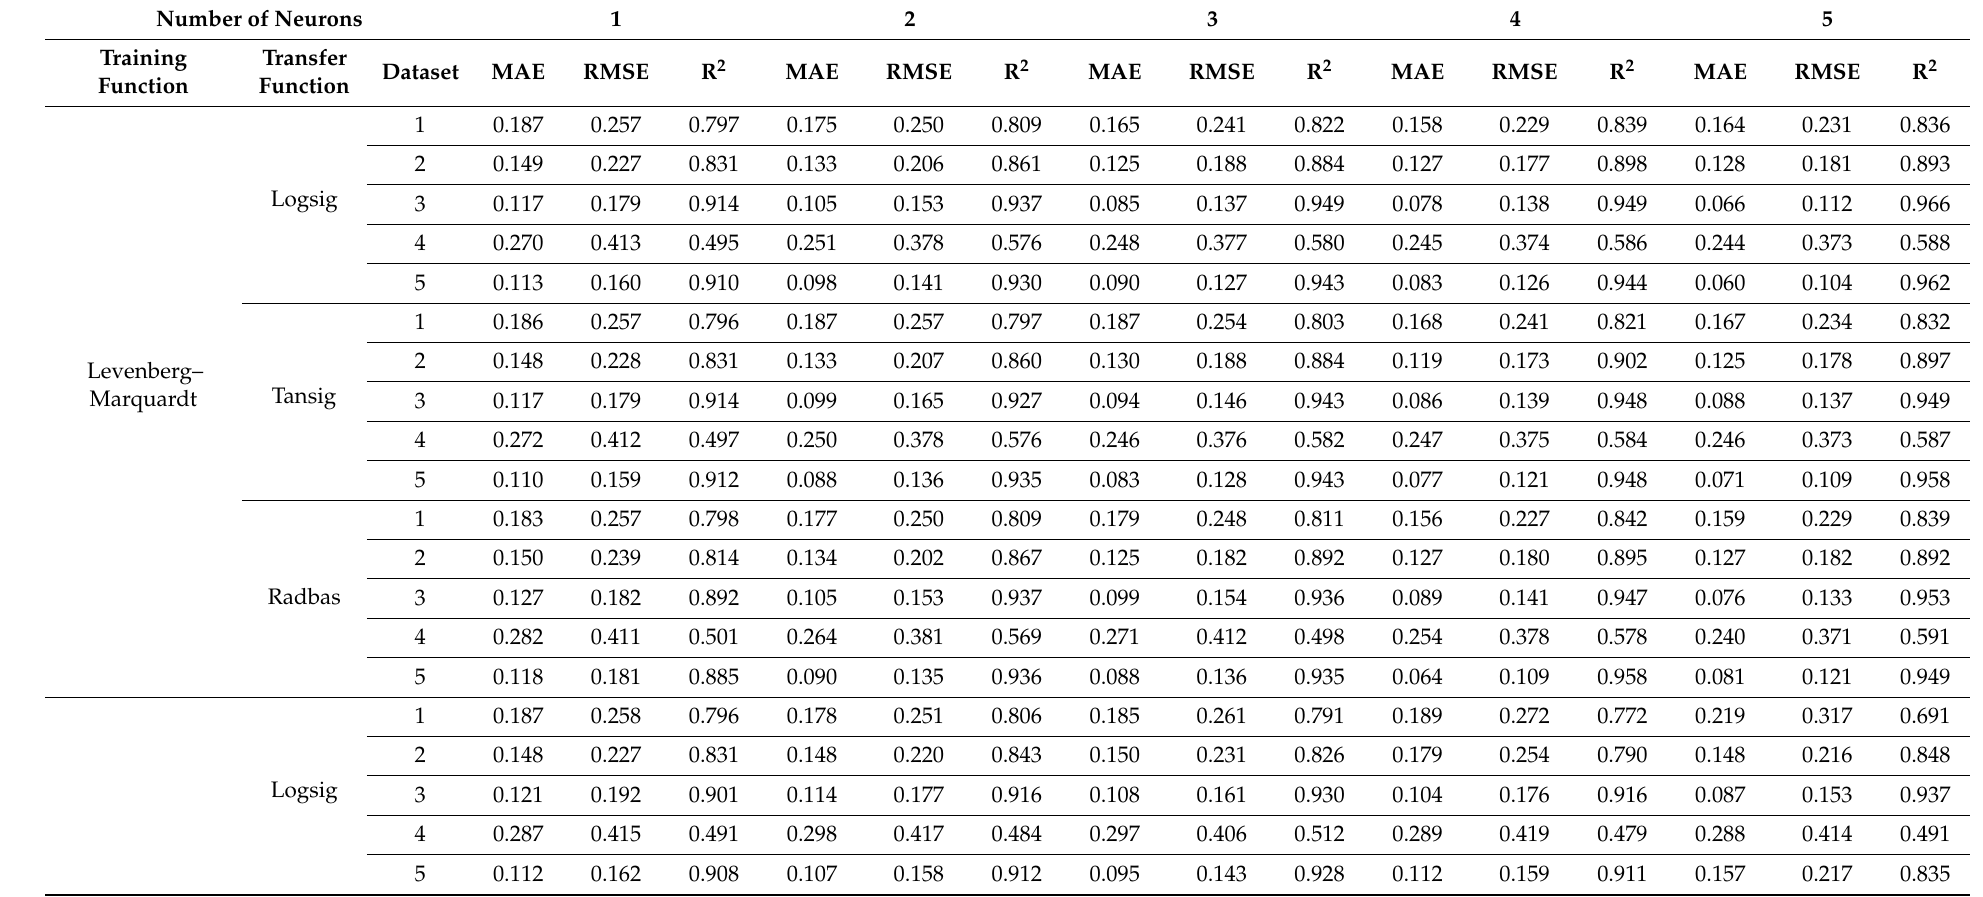
Table 6. Performance of ANN models with different transfer function and number of neurons during